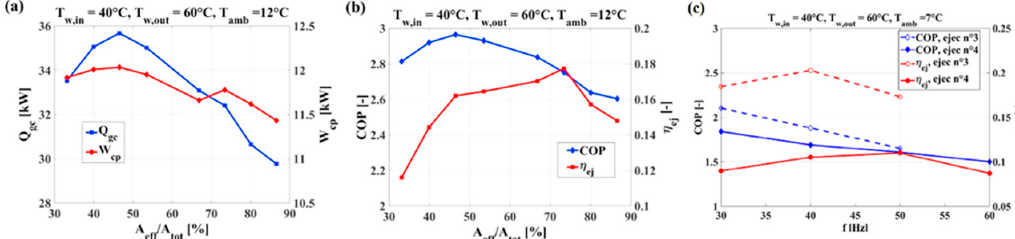
Figure 28. Schematic of the multi-ejector R744 air-to-water heat pump unit (left-hand side) and its T-s (a) and p-h (b) diagrams [76].